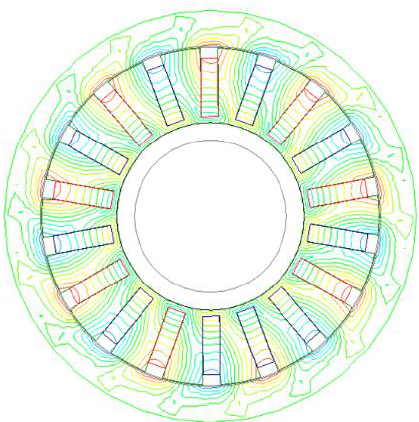
Figure 6. Distribution of eddy current density in a steady state when the rotation speed is 1500 rpm.